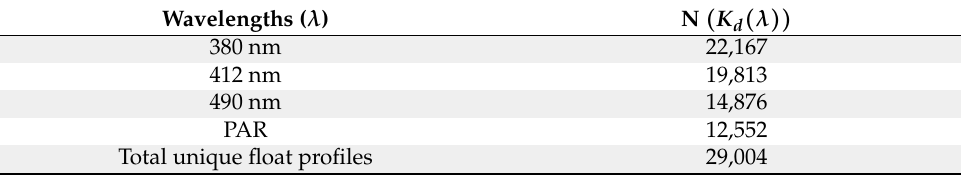
Table 2. Number of BGC-Argo float profiles passing the QC tests for each